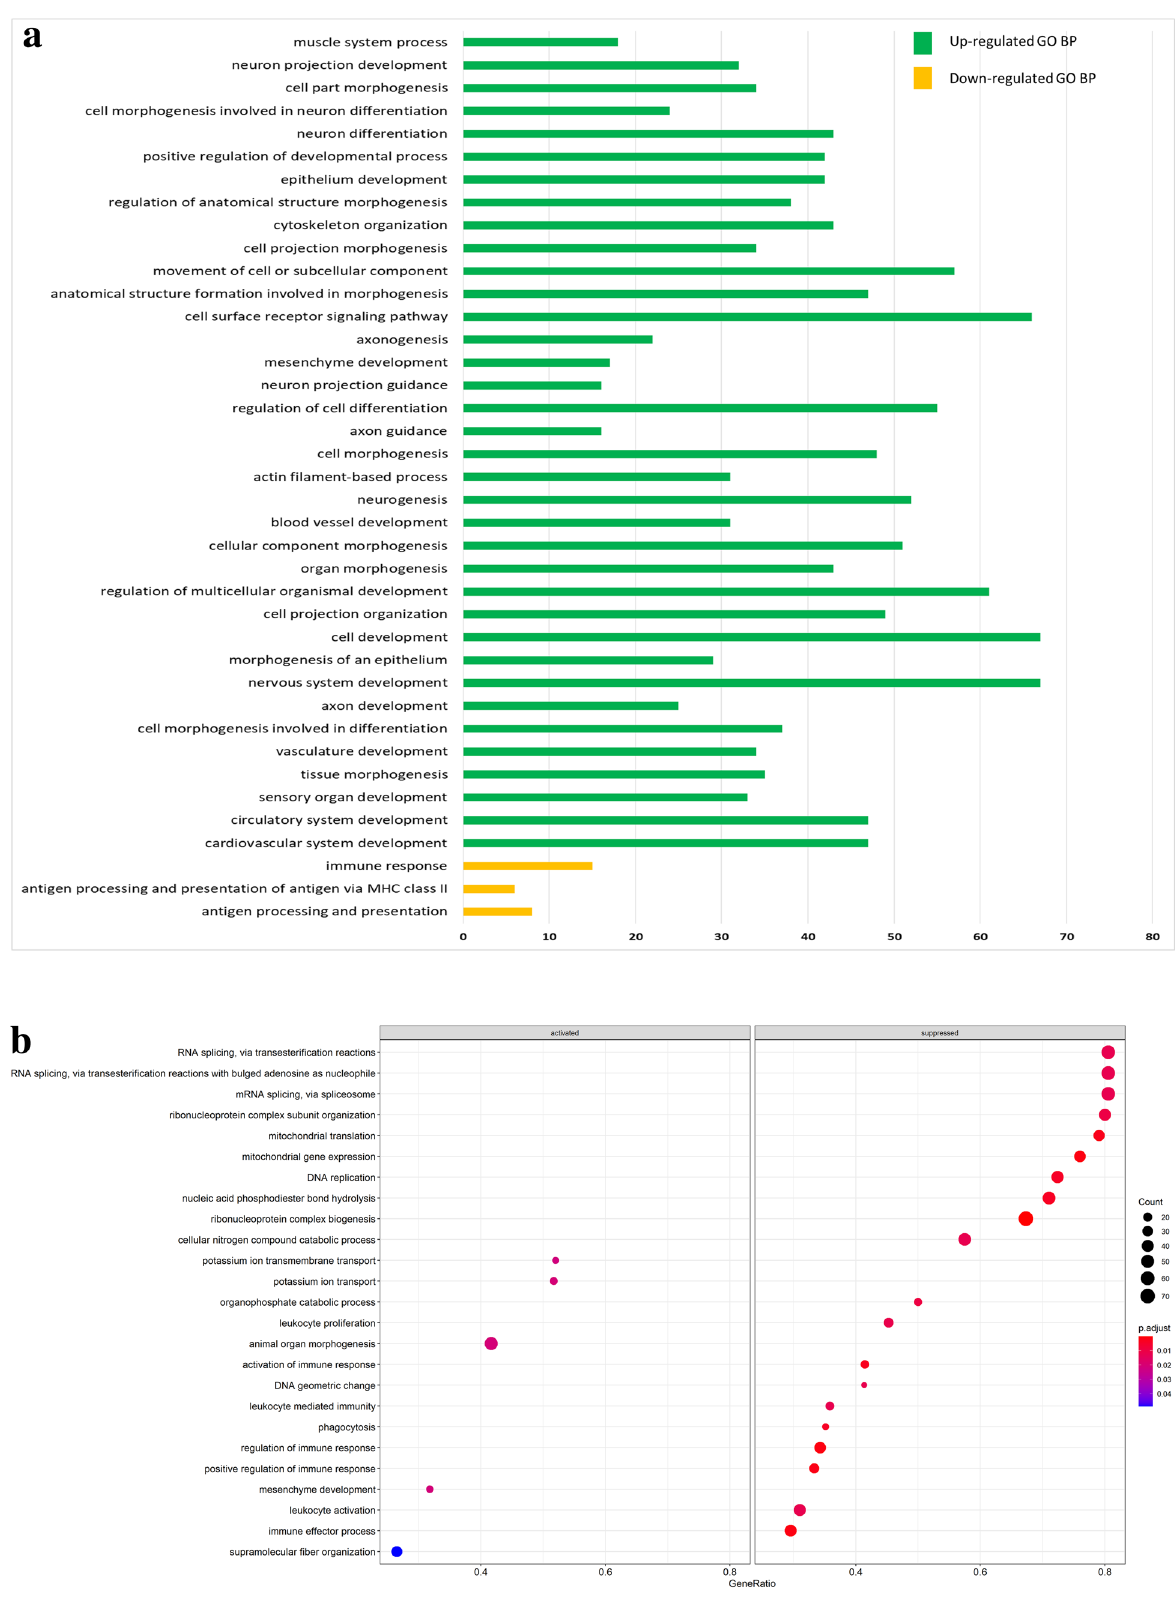
Figure 5. Functional enrichment analysis for GO biological process terms in the HD samples. ( a ) Analysis with DAVID using the up-regulated DEGs and down-regulated DEGs as the input data; the values on the x-axis represent the number of genes associated with each significant GO biological process term. ( b ) Analysis with GSEA utilizing the entire DESeq2-normalised dataset; the top 20 significantly enriched GO biological process terms are